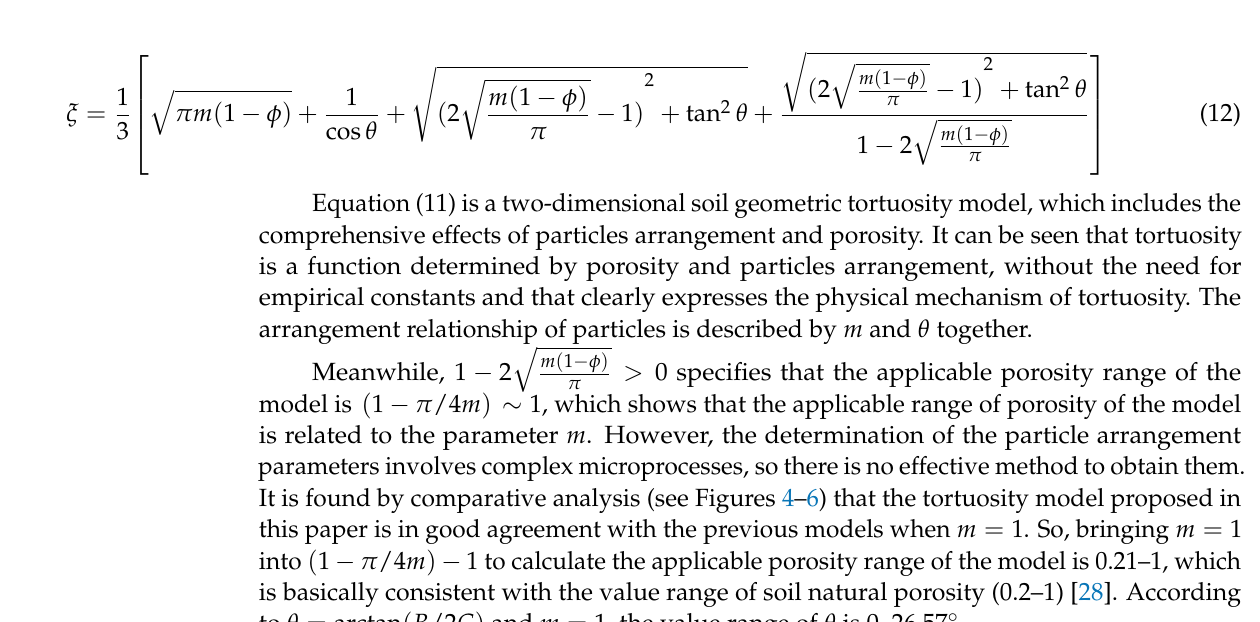
Figure 6. Comparison of the tortuosity model in this paper with other models [15–19,21–22]. 3. Comparison with Published Models In order to verify the correctness of the model, the upper and lower limit arrange- ment results of the proposed model were compared with previously published results. The comparisons results are shown in Figures 4 and 5, respectively. The results show that the tortuosity model proposed in this paper has the same changing trends and estimated values (the maximum difference is 0.2, Figure 5) as the previous tortuosity models under the two extreme conditions of soil particle arrangement. Some classical tortuosity model curves are drawn in Figure 6, and there are obvious differences between them, which is mainly caused by the differences in research methods and research objects. Further analysis of Figure 6 shows that the results from the previous tortuosity models lie between the upper limit arrangement and the lower line arrange- ment of the model established in this paper and, hence, are special cases of the current model.